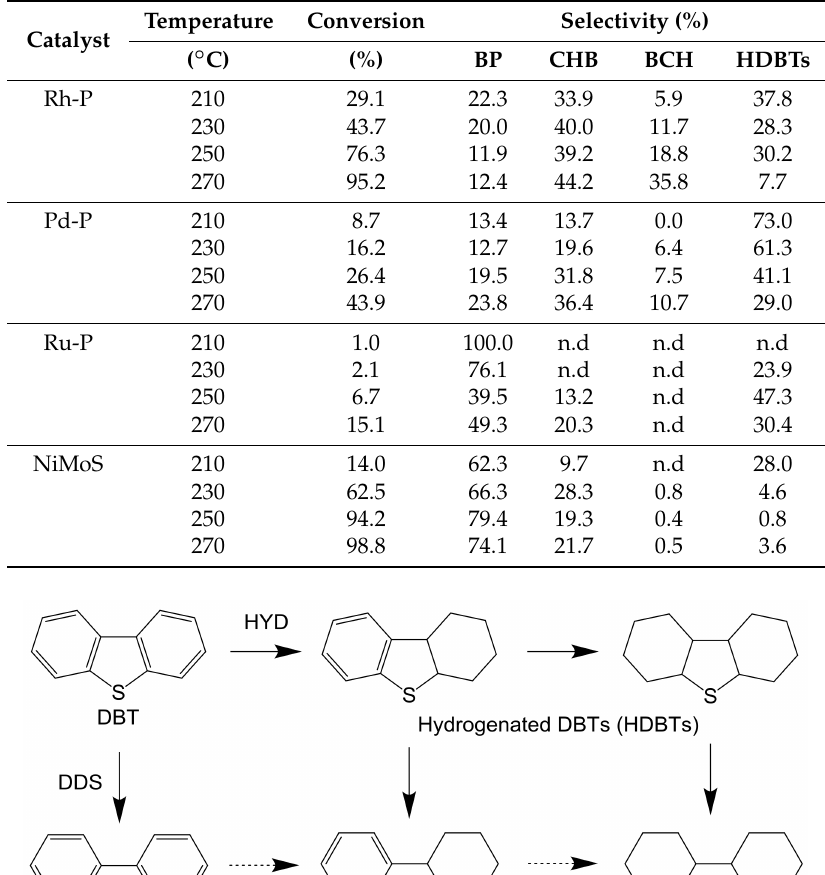
Table 2. Product selectivity in the HDS of DBT over NM-P and NiMoS catalysts at 210–270 ◦ C. n.d: not detected.